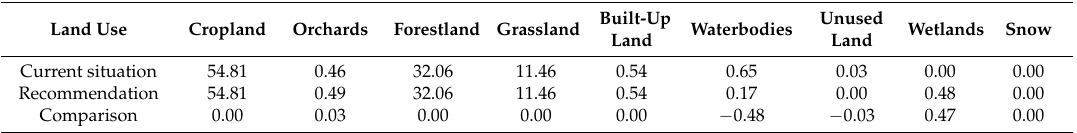
Built-Up Unused Waterbodies Wetlands Snow Land Land